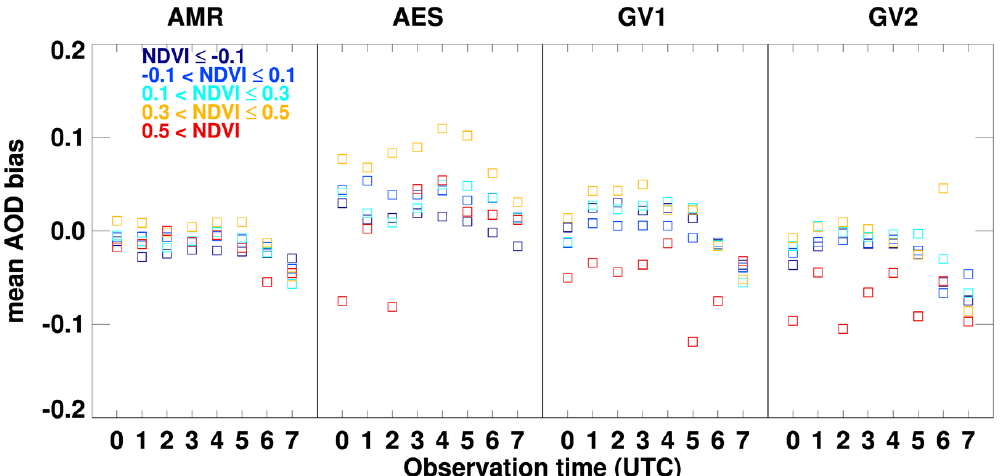
Figure 3. Systematic bias-correction values for NDVI groups and temporal bins for each satellite product from Gaussian fitting analysis used in MLE fusion. Colors represent different NDVI